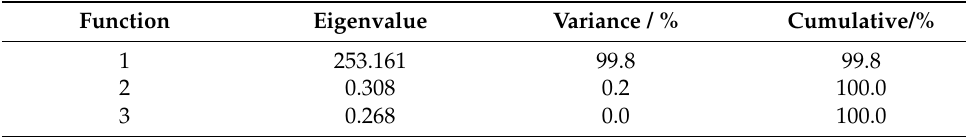
Table 3. Fisher discriminant function eigenvalues. Function Eigenvalue Variance / % Cumulative/% 1